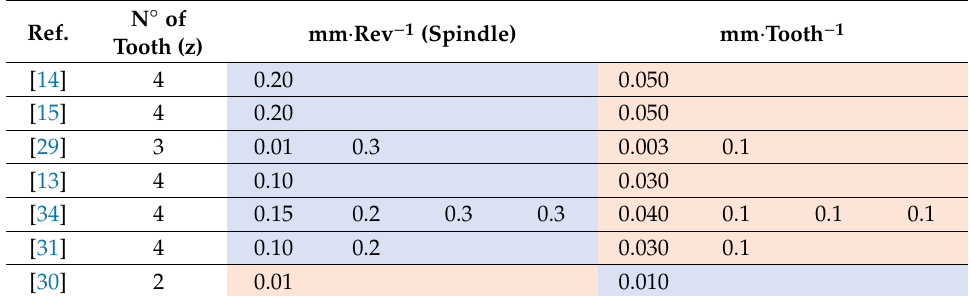
Table 3. Values provided in the publication consulted for axial movement in millimetre per tool revolution and millimetre per tooth.